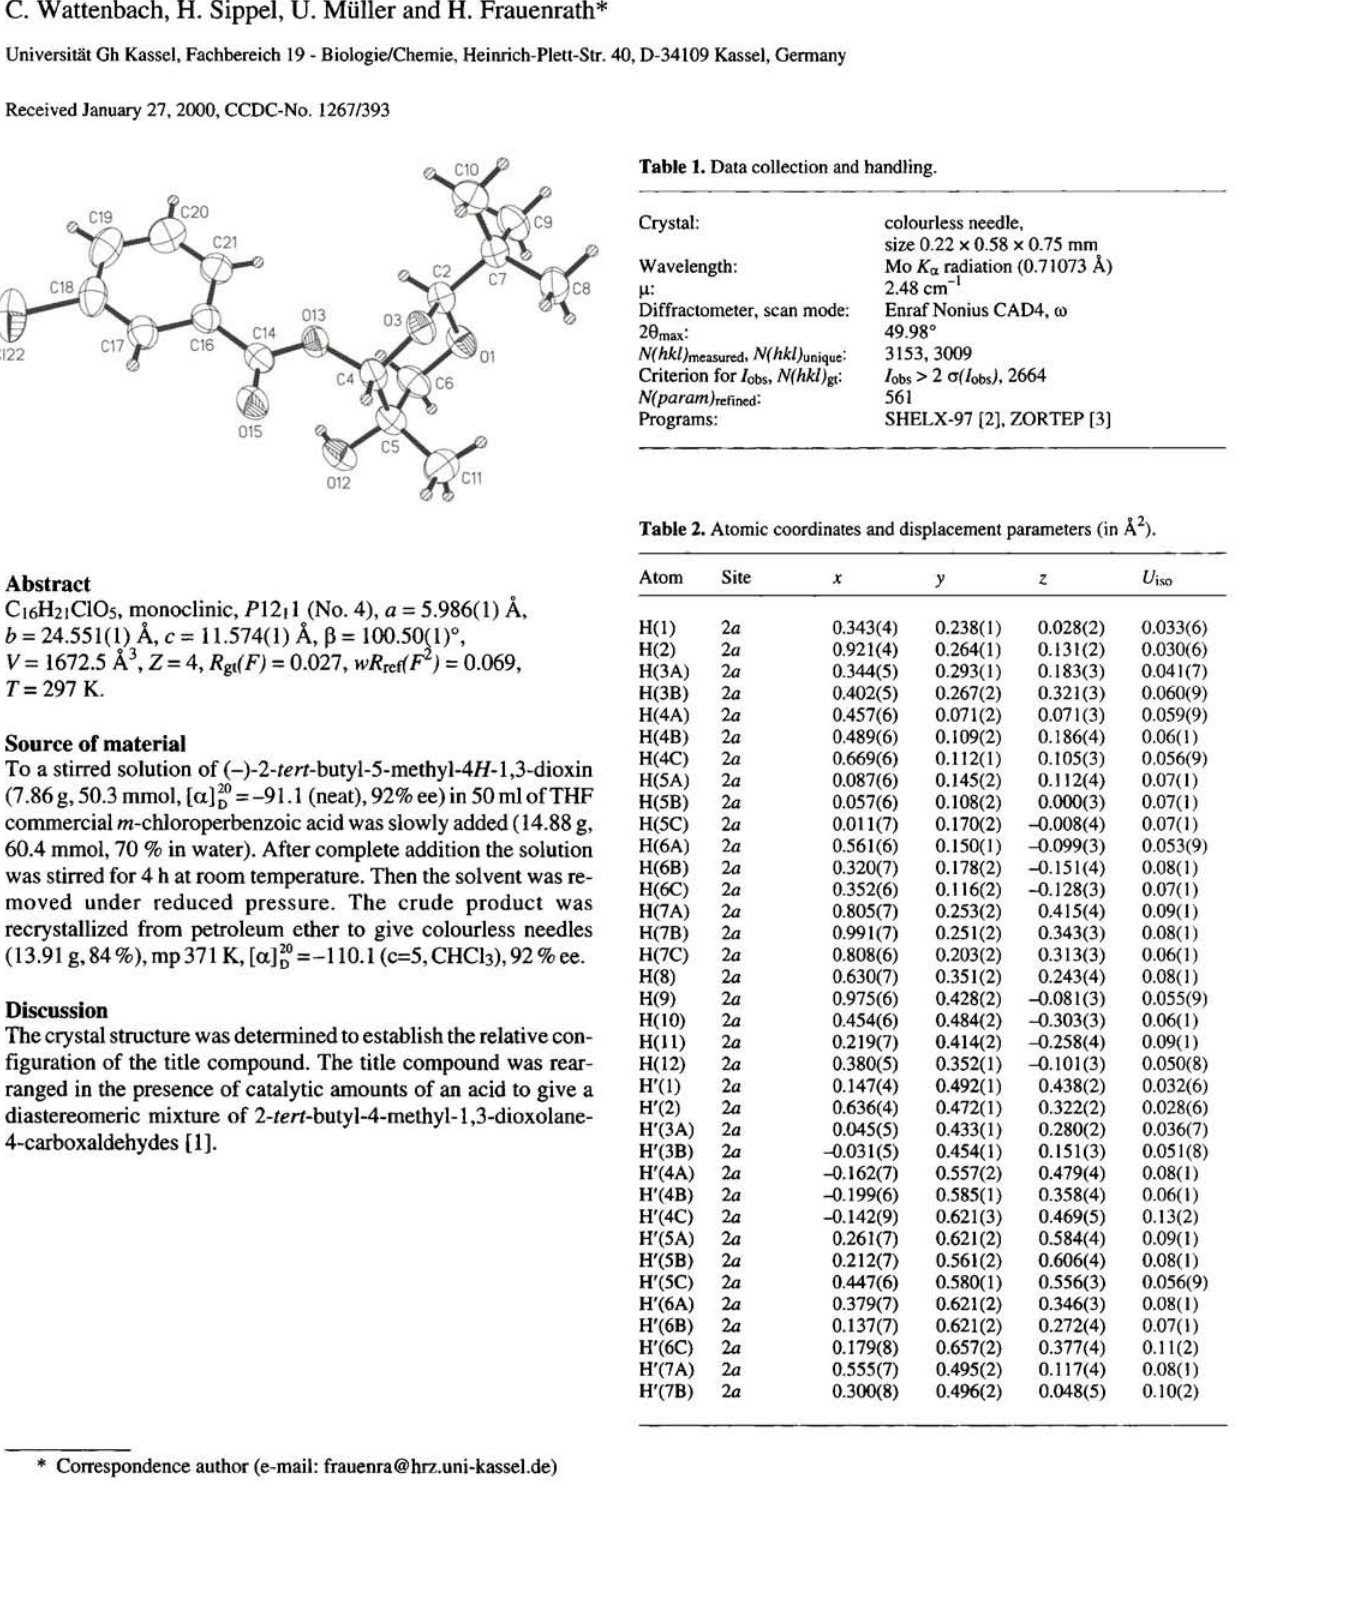
Table 1. Data collection and handling.